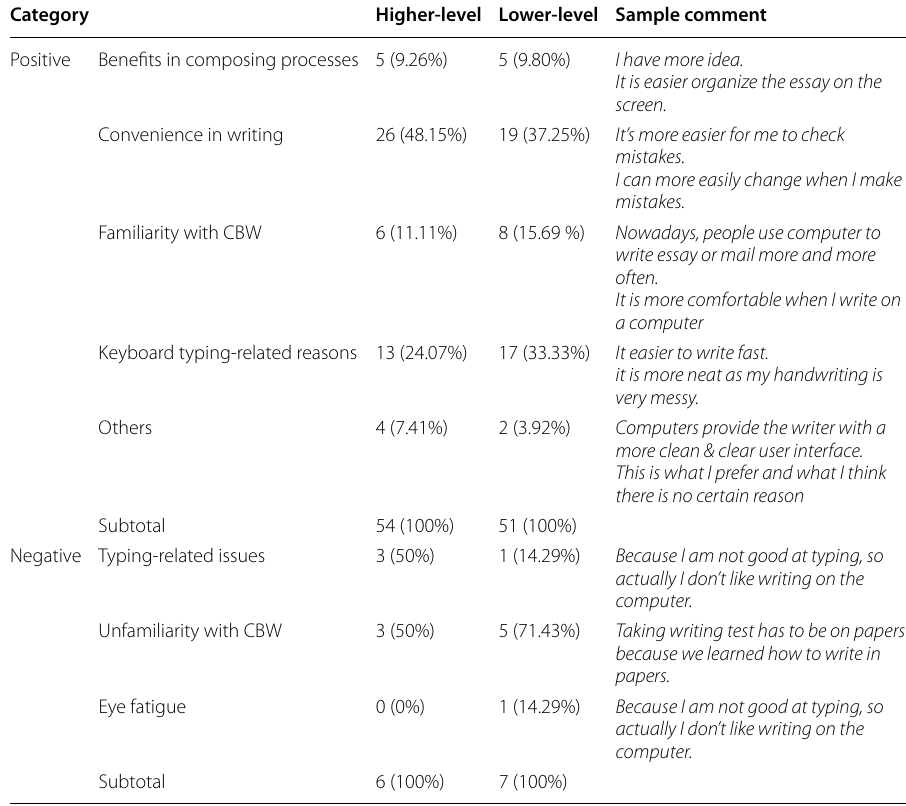
Table 5 Frequency and percent of reasons for test-takers’ presence and lack of self-confidence in CBW tests and sample comments across the levels